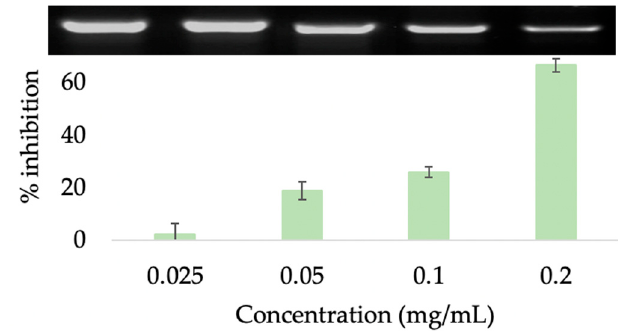
Figure 6. 5 α -reductase inhibition of (A) CBE, (B) caffeine, and (C) chlorogenic acid on HFDP cells.